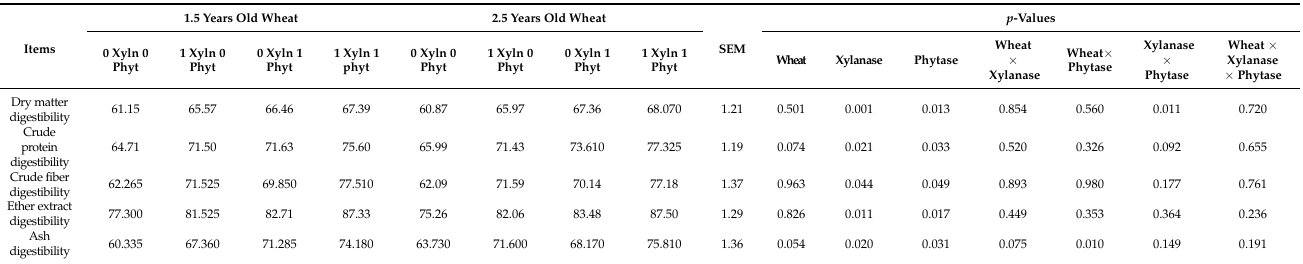
Table 4. Nutrient digestibility of broiler birds fed with stored wheat-based diet with and without the supplementation of xylanase and phytase.